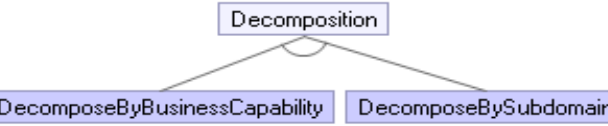
Figure 7. Feature diagram of decomposition.